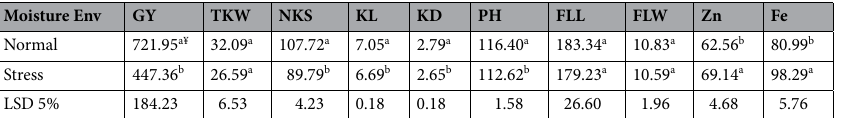
Table 1. Mean comparison of traits under two moisture environments. GY, Grain yield (g/m 2 ); NKS, Number of kernel per spike; TKW, Thousand kernel weight (g); KL, Kernel length (mm); KD, Kernel diameter (mm); PH, Plant height (cm); FLL, Flag leaf length (mm); FLW, Flag leaf width (mm); Zn, Grain zinc content (µg/g); Fe, Grain iron content (µg/g). ¥ For each trait, means followed by the same letter are not significantly different, using LSD test at 5% level of